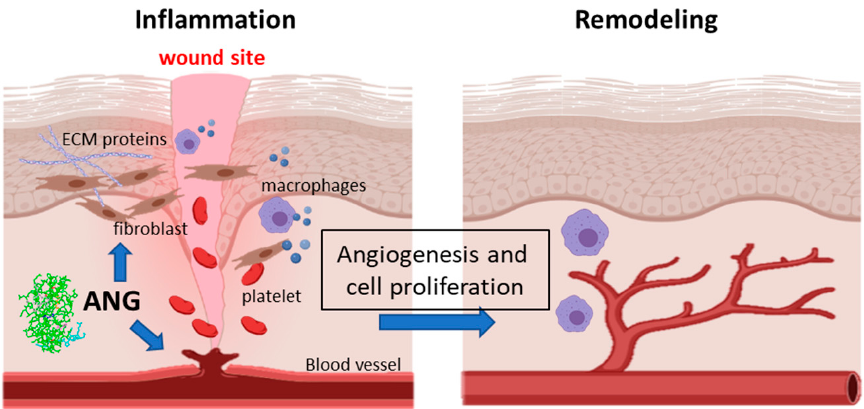
Figure 5. Angiogenin promotes wound healing by inducing angiogenesis and cell migration and by activating fibroblast cells to produce ECM proteins (collagen, fibrin, fibronectin).